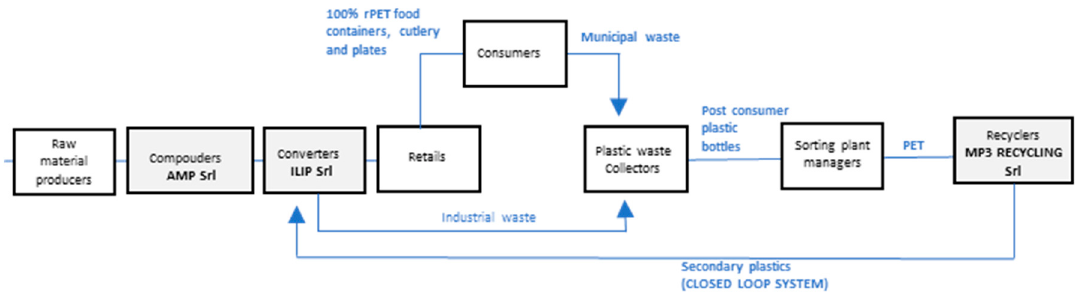
Figure 1. Closed loop supply chain – ILPA Group.